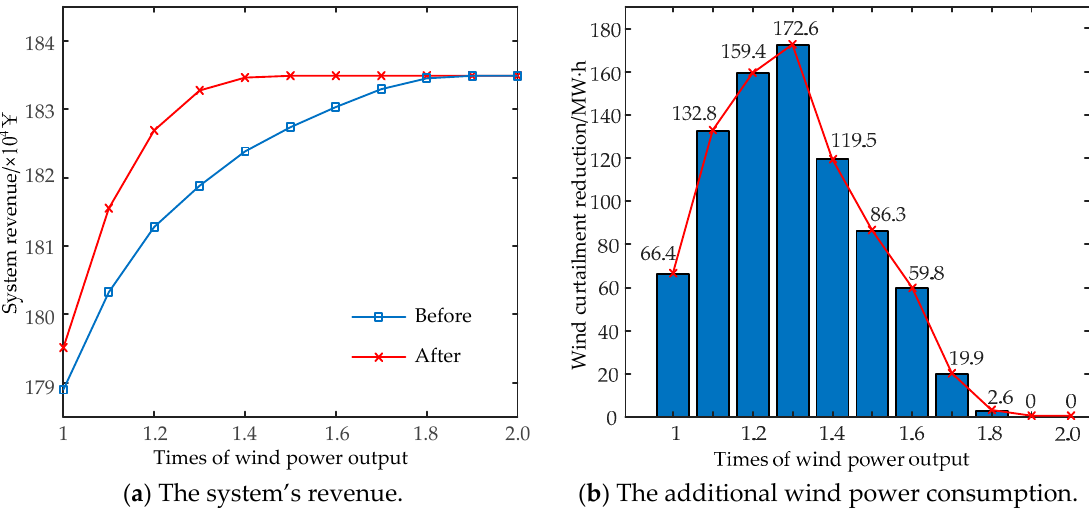
Figure 13. The system revenue ( a ) and the additional wind power consumption ( b ) under the two strategies with different times of wind power.